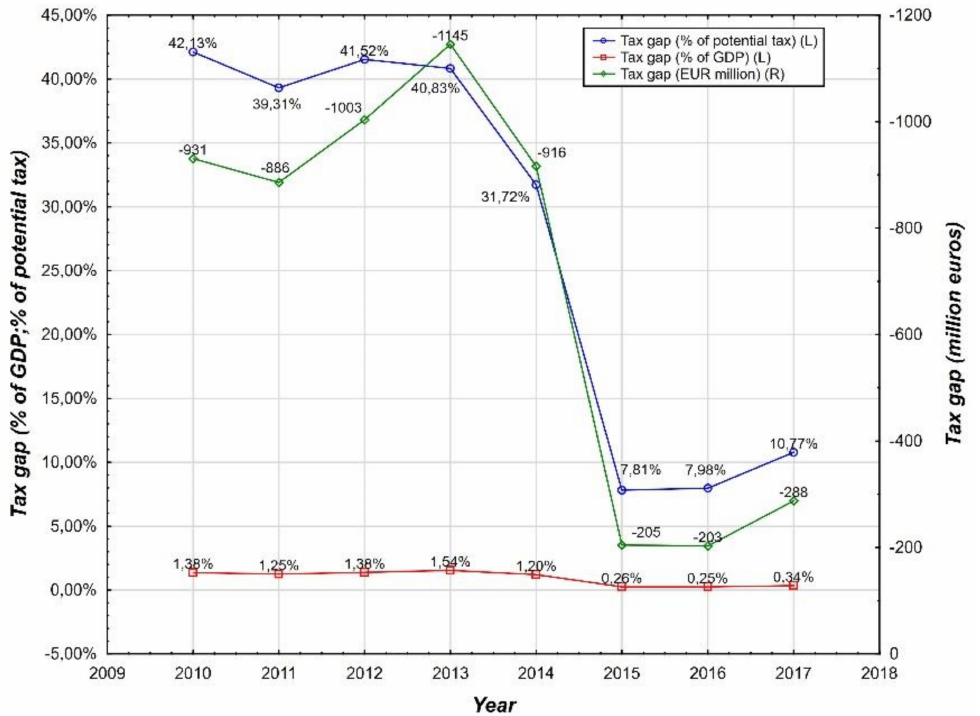
Figure 5. The tax gap of legal